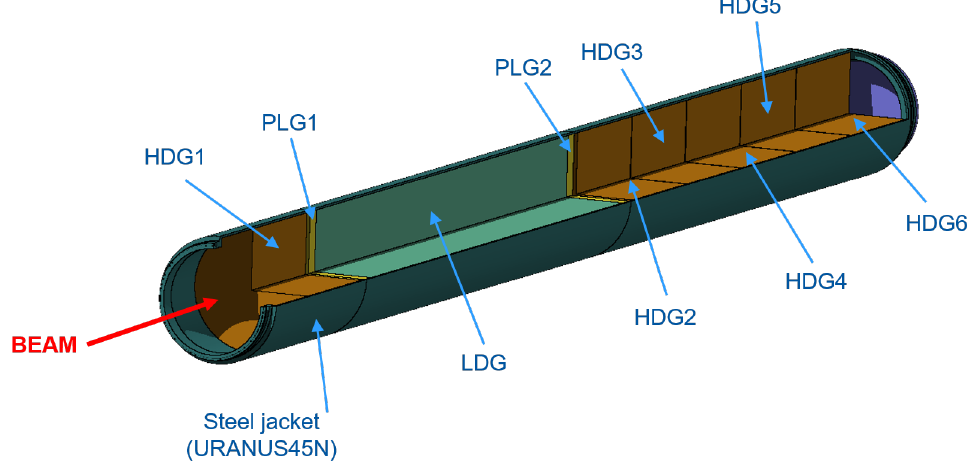
Figure 7. Overview of the LHC TDE core, particular of the High- (HDG) and Low-Density Graphite